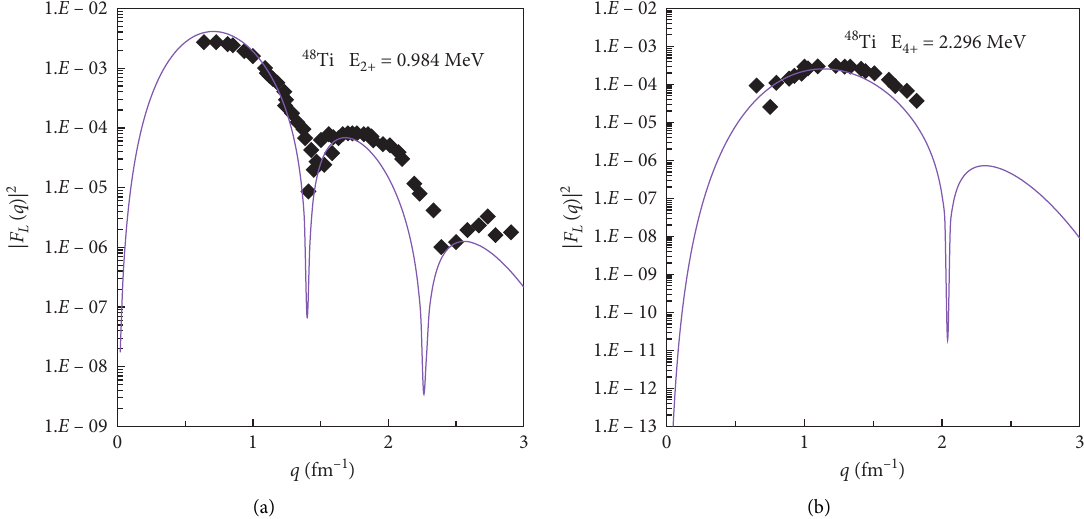
Figure 2: Inelastic longitudinal form factors of 48 Ti. (a) E(2 + ) transition, the practical data are taken from reference [4]. (b) E(4 + ) transition, the practical data are taken from reference